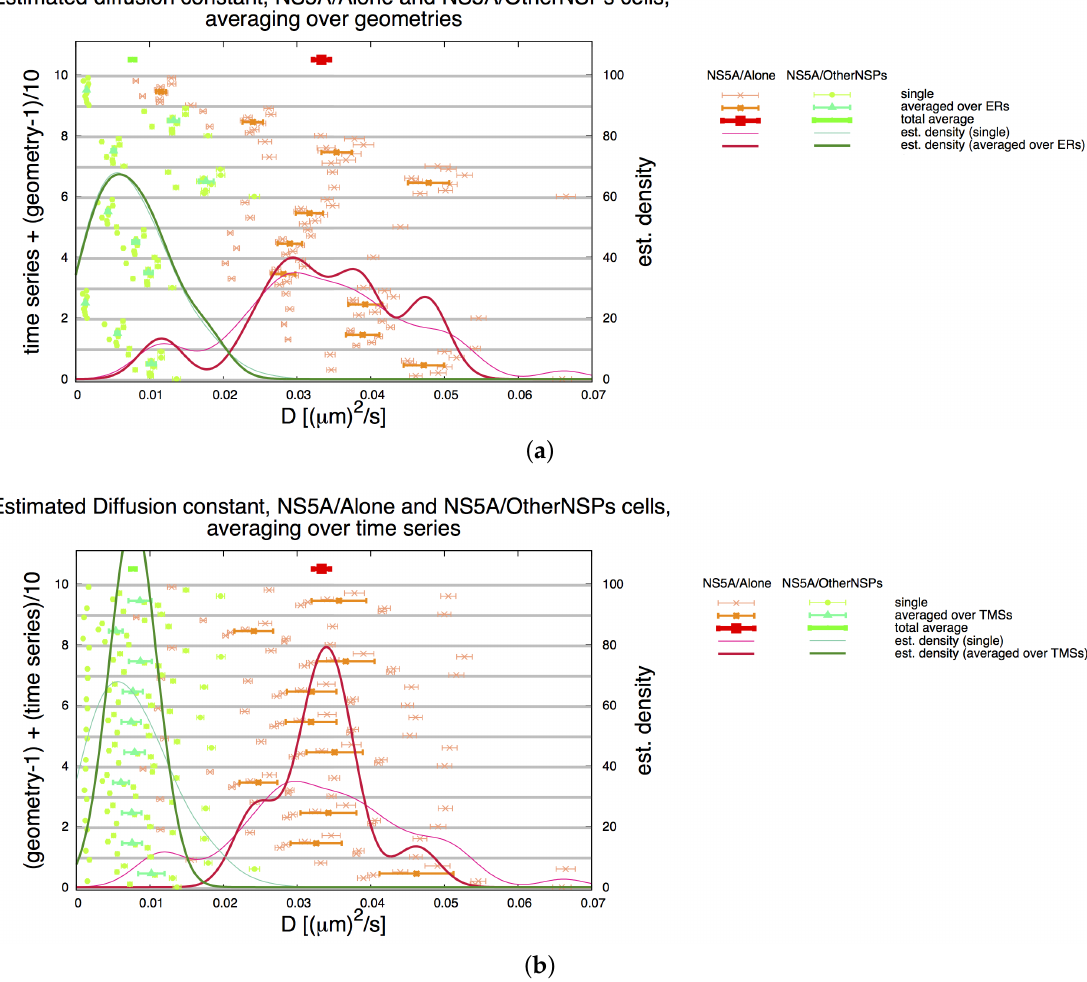
Figure 7. Averages for NS5A diffusion constant D ns5a estimation on the ER surface as described in Sections 2.2 and 3.3: Analyzed separately for NS5A/Alone (red— D A ) and NS5A/OtherNSPs ns5a (green— D N ). Thin points and error bars correspond for ( a , b ) to estimated values for D ns5a (shown ns5a on x axis) for the combination of single TMS with single geometries (indicated on the left y axis, note different combinations for geometry and TMS). Aggregating over all TMS and ER geometries yields distributions (thin continuous lines, scale shown on right y axis) which are identical in both cases. ( a ) Each “row” corresponds to one time series combined with all ER geometries. (For example, the left y axis value 2.5 corresponds to the combination of time series #2 and ER geometry E 6 ). Half thick symbols (shown in the middle of each time series region) correspond to the averaged values over all geometries D ns5a | G for the respective TMS. Aggregating these averages over all TMS yields distributions (thick continuous lines, scale shown on right y axis). Thick symbols (shown on top) correspond to the averaged values D ns5a . ( b ) Each “row” corresponds to one ER geometry combined with all TMS. (For example, the left y value 2.5 corresponds to ER geometry E 3 and TMS # 5). Half thick symbols (shown in the middle of each ER geometry region) correspond to the averaged values over all TMS D ns5a | T for the respective ER geometry as reported in Section 2.6. Aggregating these averages over all ER geometries yields distributions (thick continuous lines, scale shown on right y axis). Thick symbols (shown on top) correspond to the averaged values D ns5a . Note: The total averages are identical for ( a , b ) and are reported in Table